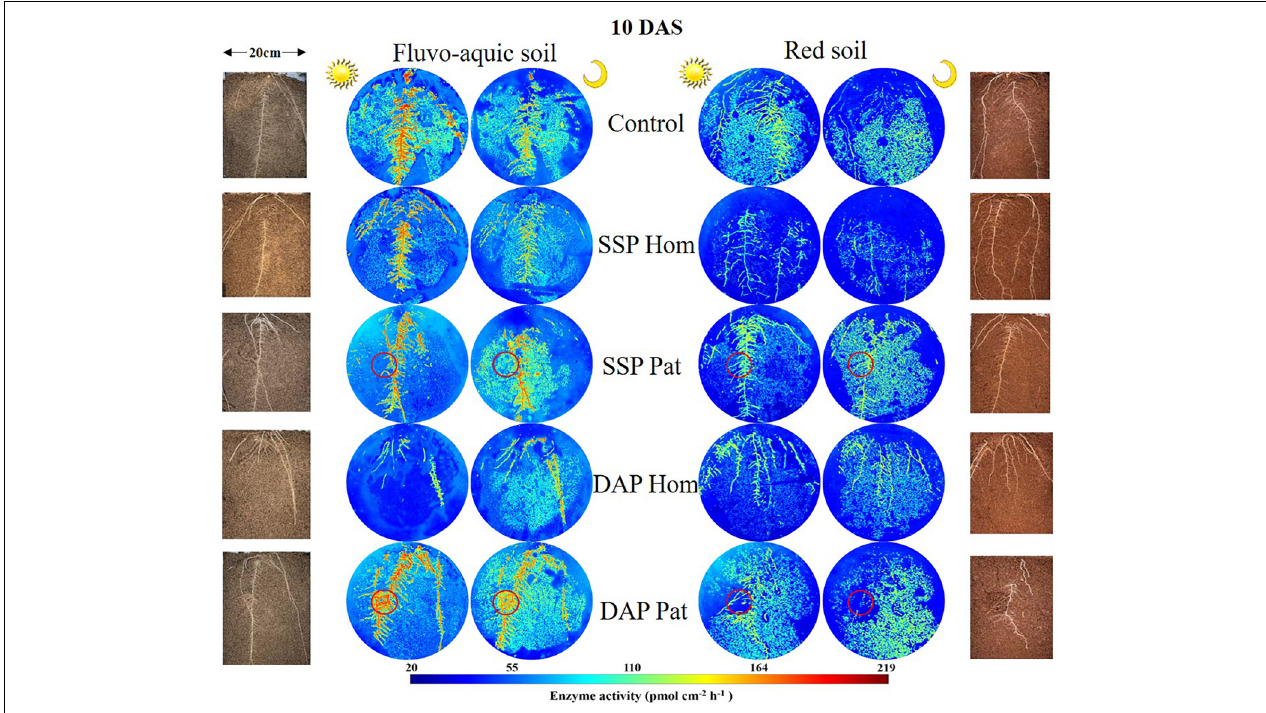
FIGURE 5 | Distribution of acid phosphatase (middle) and maize roots grown in rhizoboxes (left and right), in fluvo-aquic soil and red soil, on 10 DAS. The first and third columns of zymogram were taken on noon, and the second and fourth columns of zymogram were taken at midnight. Lines from top to bottom represent maize grown in soil with no phosphorus addition, superphosphate homogenized application in the whole soil, superphosphate localized application in the P-rich patches (red circle), diammonium phosphate homogenized application in the whole soil, diammonium phosphate localized application in the P-rich patches (red circle), respectively. The color map is proportional to acid phosphatase activity (pmol cm − 2 h − 1